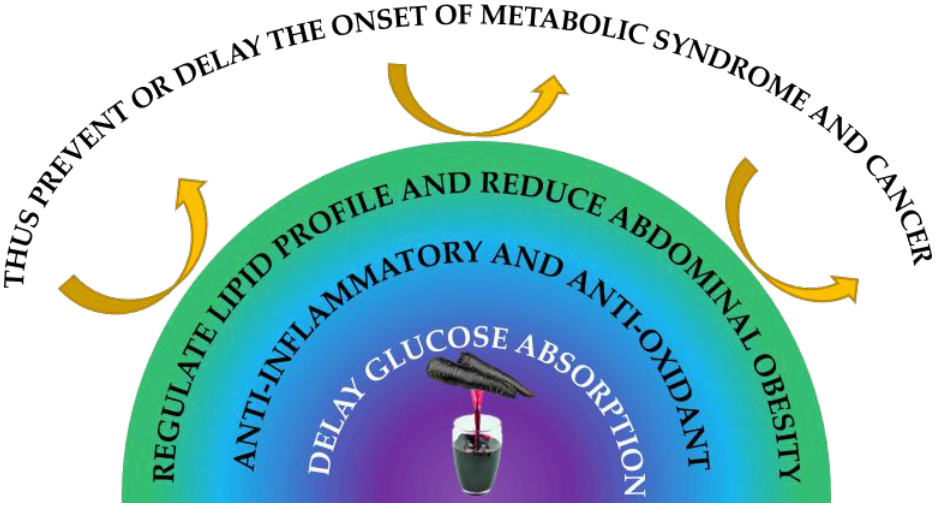
Figure 2. A graphical representation of the nutraceutical benefits of purple carrot against MetS and